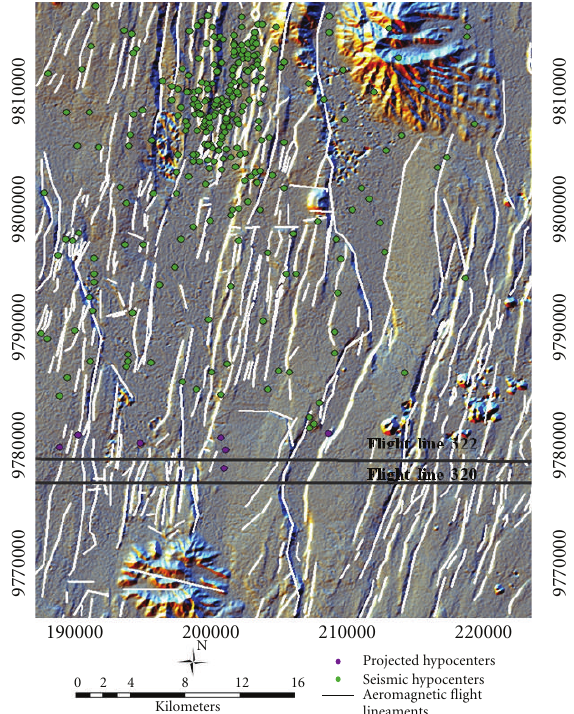
Figure 15: Hill-shade AsterDEM image showing the lineaments and seismic hypocenters distributions from Ibs-von Seht et al. [7] around Lake Magadi. The brown dots are the reprojected hypocenters along the aeromagnetic flight lines.